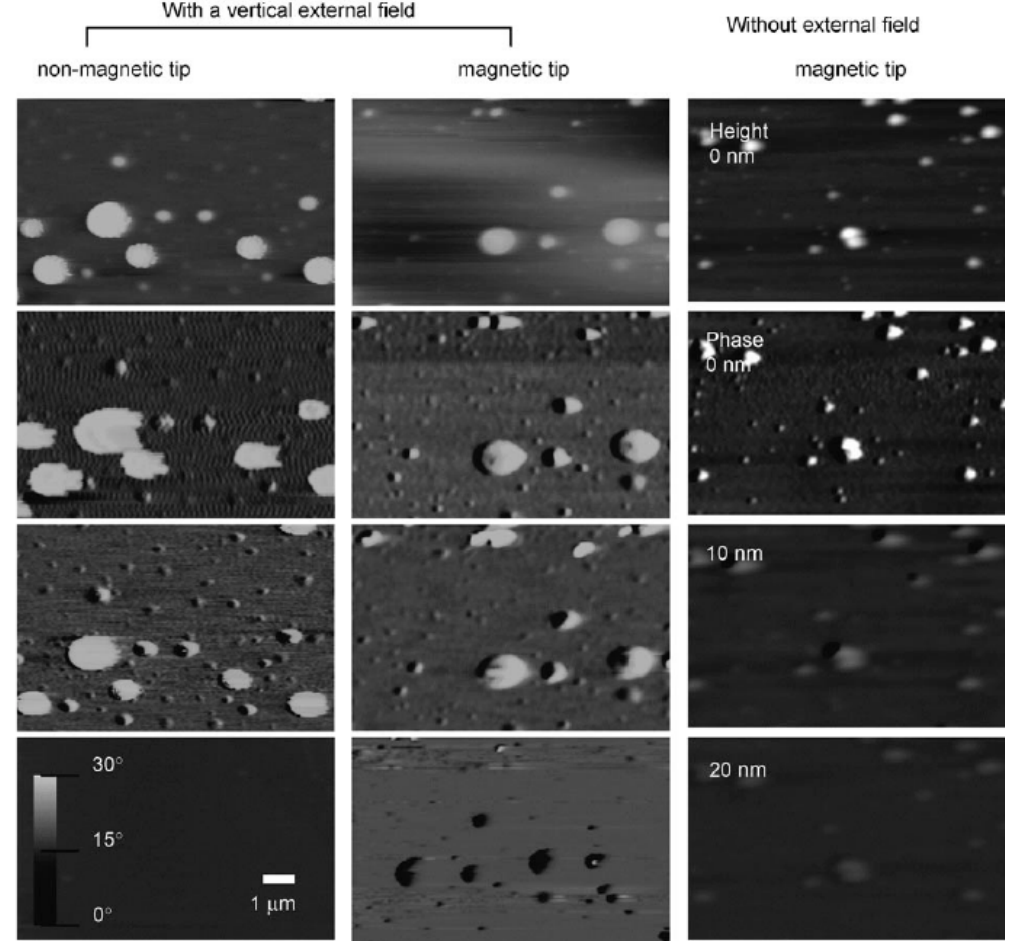
Figure 5. Tapping ‐ mode height (row 1) and phase images (rows 2 to 4) of SPNs obtained in lift ‐ mode using a nonmagnetic or magnetic AFM probe with or without the presence of an externally applied vertical magnetic field, as indicated. In each series of images, the amplitude of cantilever oscillations was kept constant for various lift heights. Lift height for each row of images is indicated on the top left of the images in Column 3. Grayscale for phase values and scale bar for image size are shown as insets in the bottom ‐ left image and apply to all panels. Figure was reprinted from Ref. [77] with permission from Wiley Online Library.